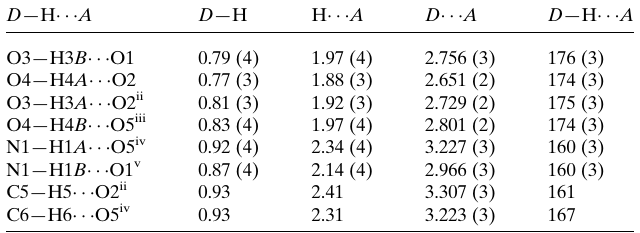
Table 2 Hydrogen-bond geometry (A˚ , (cid:5) ).